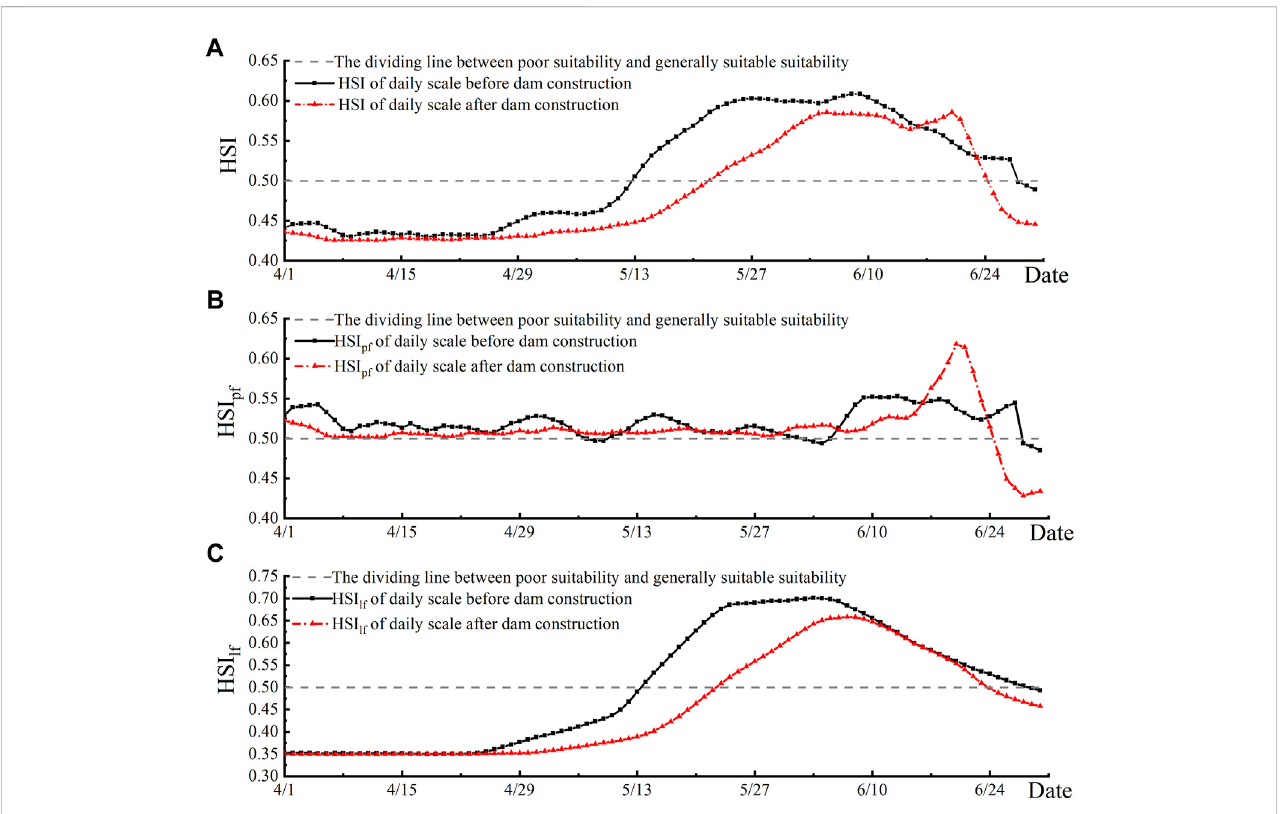
FIGURE 6 Simulation of the habitat suitability index ( HSI ), parent fi sh spawning suitability index ( HSI pf ), and larval fi sh development suitability index ( HSI lf ) of the Yellow River carpat a daily scale during April1 – June 30 from 1980 – 1990 (before dam construction) to 2006 – 2018 (after dam construction). (A) Comparison ofthedaily-scalehabitatsuitabilityindex( HSI ); (B) comparisonofthedaily-scaleparent fi shspawningsuitabilityindex( HSI pf ); (C) comparisonofthedaily-scale larval fi sh development suitability index ( HSI lf